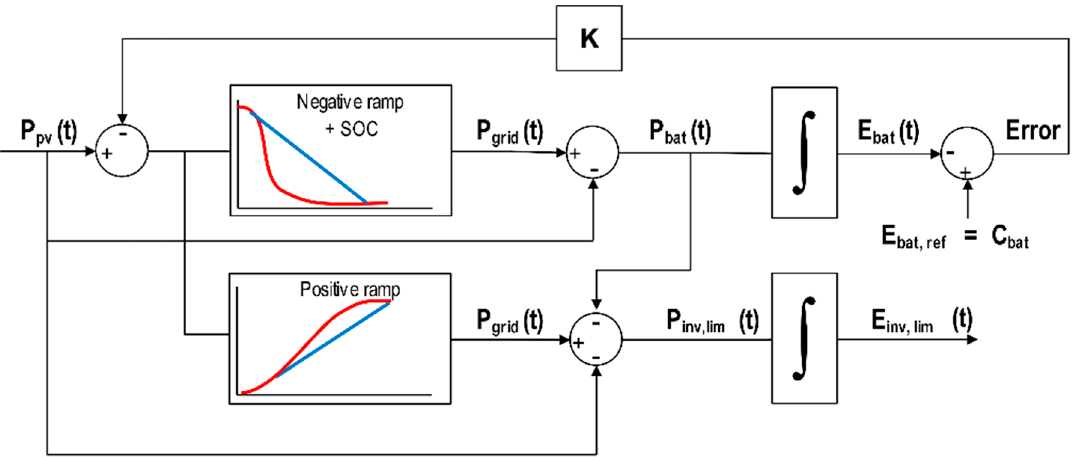
Figure 5. Control diagram of Strategy 1.